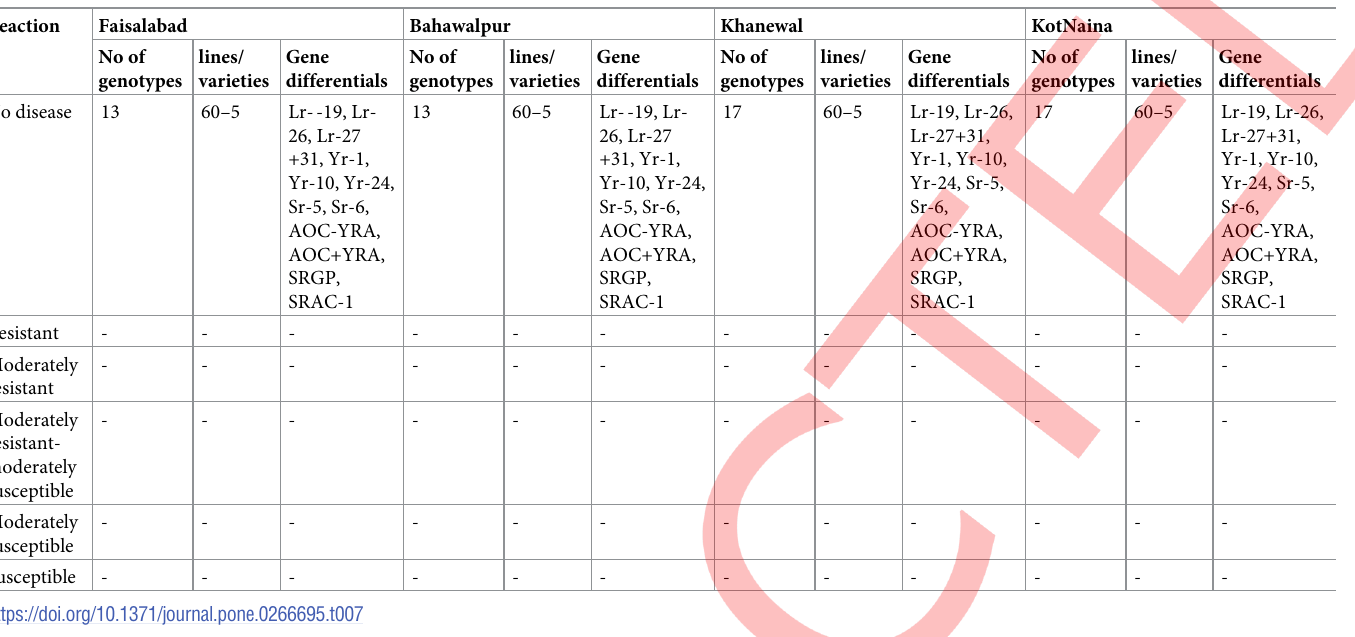
Table 7. Common leaf rust resistant genotypes at all locations during both years 2016–17 and